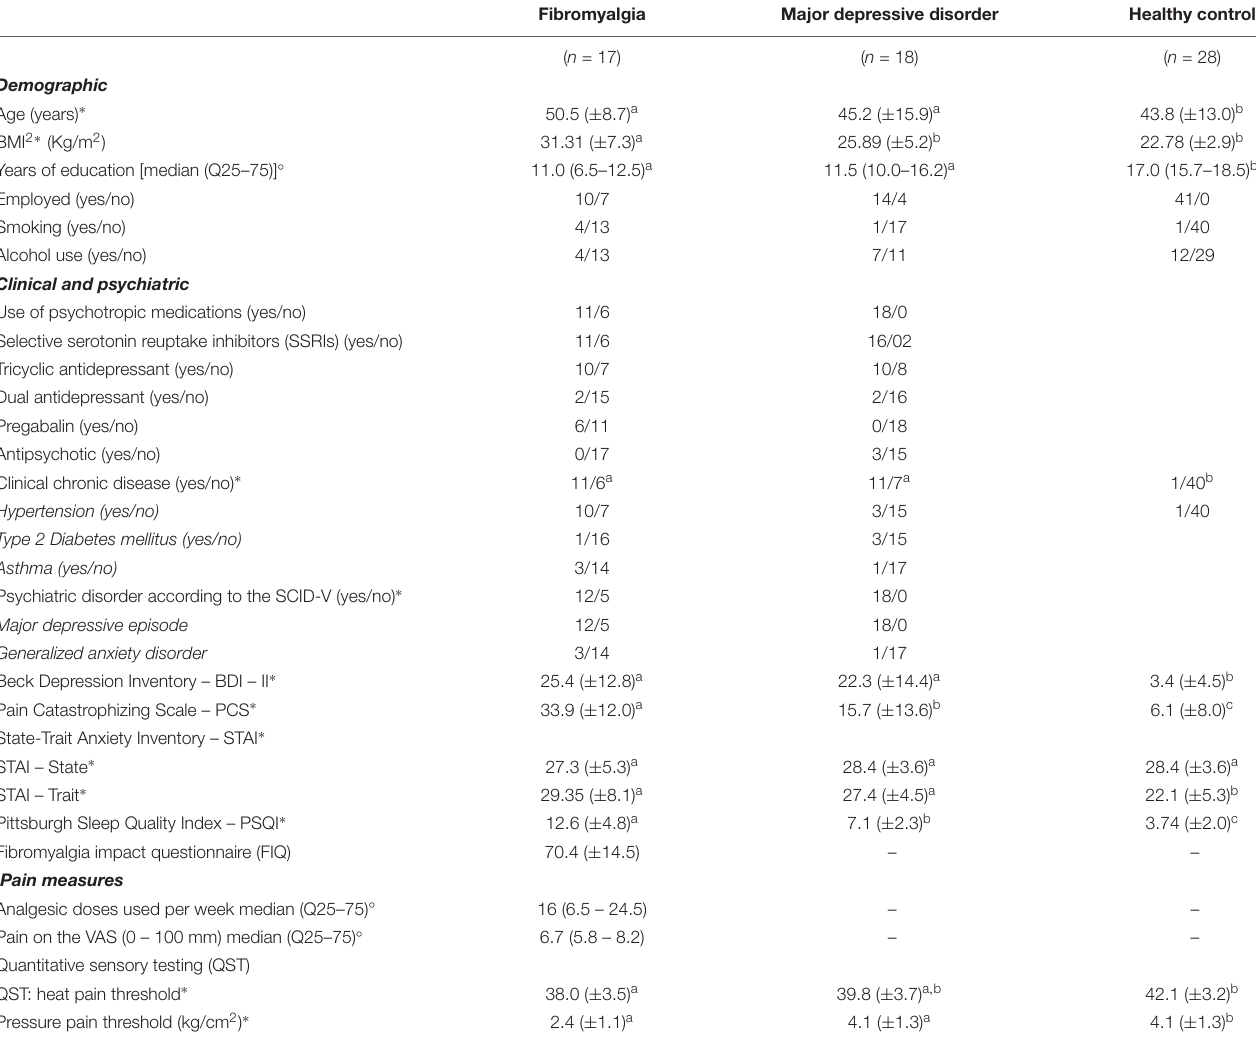
TABLE 1 | Demographic characteristics.